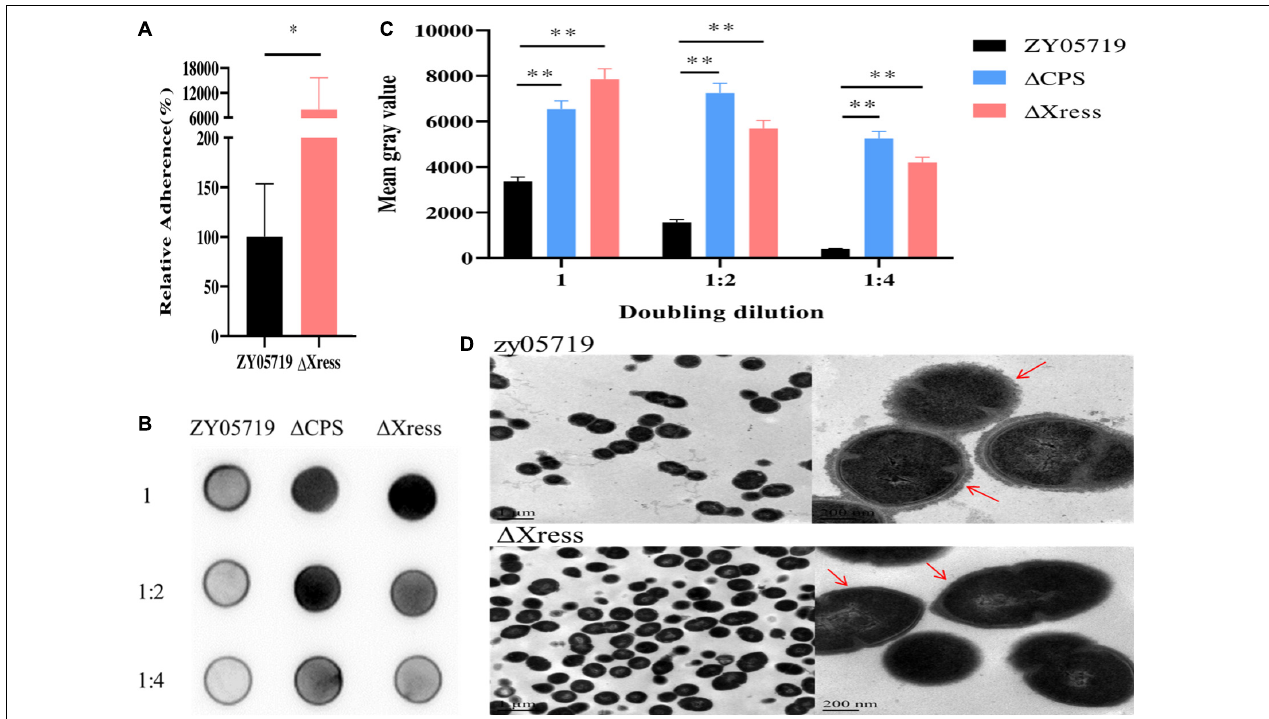
FIGURE 6 | Capsule synthesis is reduced in the (cid:49) Xress mutant. (A) Adhesion of (cid:49) Xress to Hep-2 epithelial cells. The adhesion rate of the ZY05719 strain was significantly lower than that of the (cid:49) Xress strain. Values represent the average of three independent replicates. Two-tailed unpaired Student’s t -test: ∗ P < 0.05. (B) Dot-blot membrane showing capsule productions in ZY05719, (cid:49) CPS (control), and (cid:49) Xress . Dilutions of cells were made in PBS and spotted onto nitrocellulose membranes; the cells were then fixed and the membranes were probed with the absorbed antibody. (C) The quantitative analysis of Dot-blot result. Two-tailed unpaired Student’s t -test: ∗∗ P < 0.01. (D) Transmission electron micrographs showing capsule thickness in ZY05719 and (cid:49) Xress ; scale bars, magnification level. The scale bars indicate the magnification